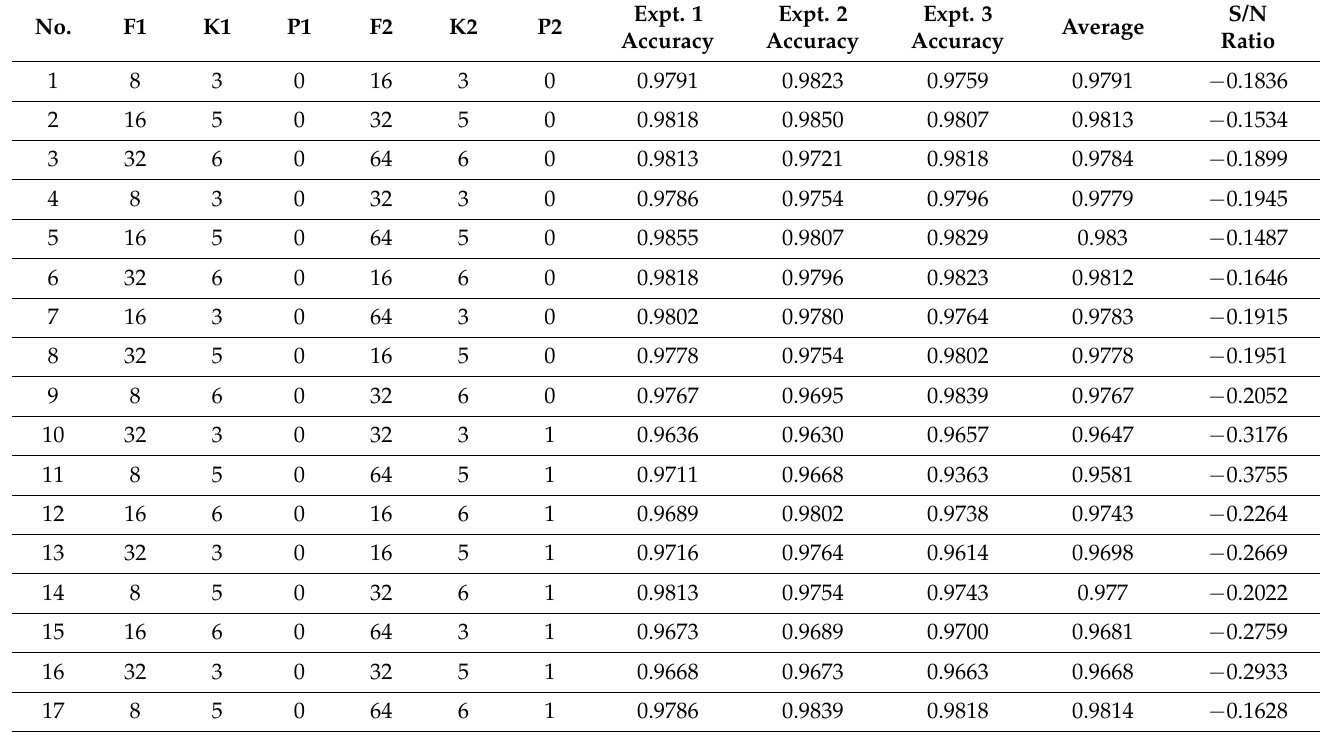
Table 6. Accuracy values and S/N ratios for different parameter